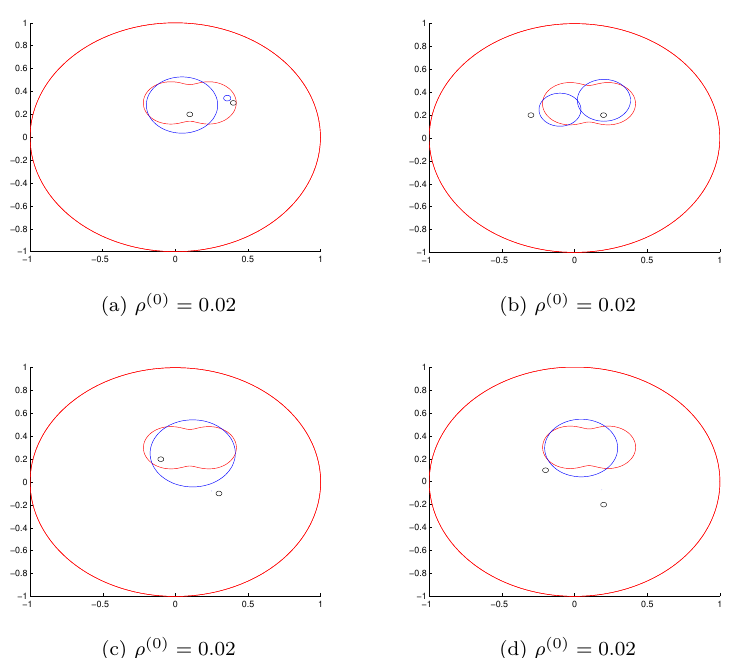
Figure 2. Apply TRA to detect the number of the coefficient with piecewise constant along with exact solution (red), initial guess (black) and recovered solution (blue), respectively for Example